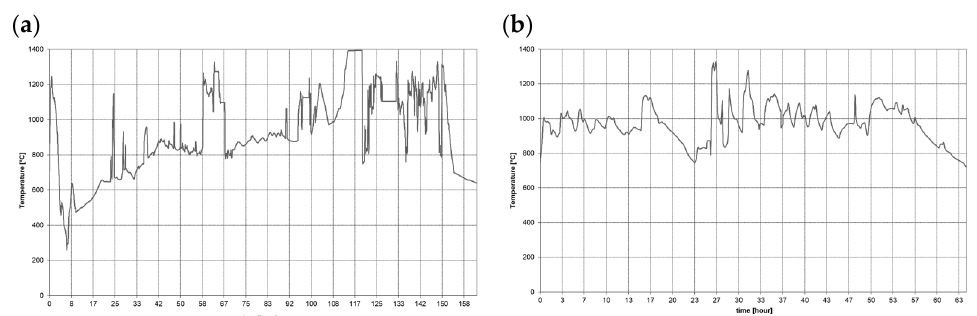
Figure 11. The maximal temperature course in the gasification channel ( a ) the first experiment ( b ) the second experiment.